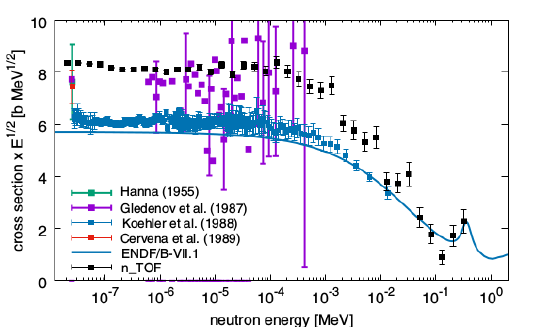
Figure 6. The cross section of 7 Be(n, p) 7 Li compared with the previous measurements and ENDF evaluations. Only the statistical uncertainties are shown in the figure. Reprinted figure with permission from: Damone et al. (The n_TOF Collaboration), Phys. Rev. Lett. 121, 04270—2018. Copyright (2018) by the American Physical Society.